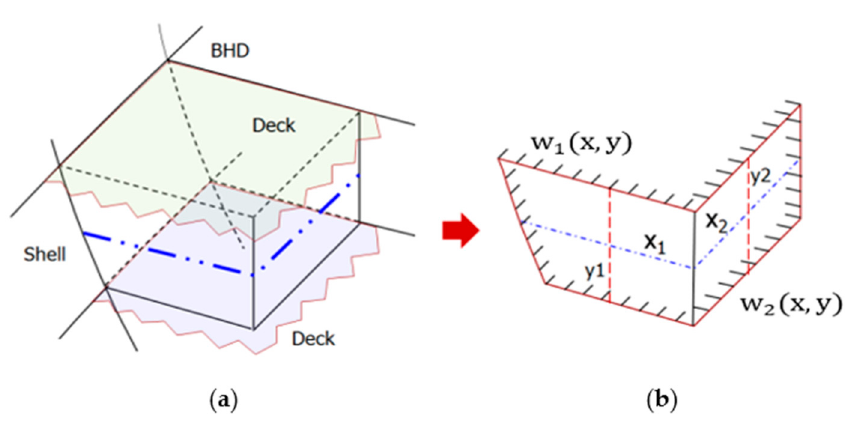
Figure 3. The arrangement of the tank in a ship: ( a ) the general shape of tank; ( b ) simplification of the ship tank shape.